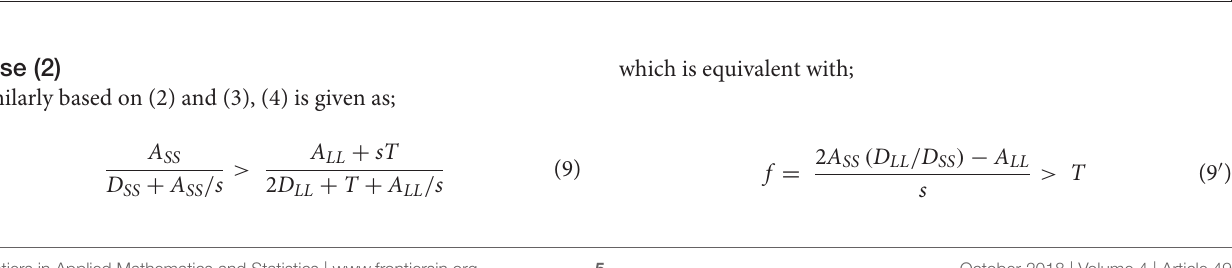
FIGURE 3 | Areas of parameters (amount-to-delay ratio, A / D ratio) for SS (abscissa) and LL (ordinate) where SS gives rise to a higher profitability than LL , for Case (1), Case (2), and Case (3), respectively. See text for further explanations.